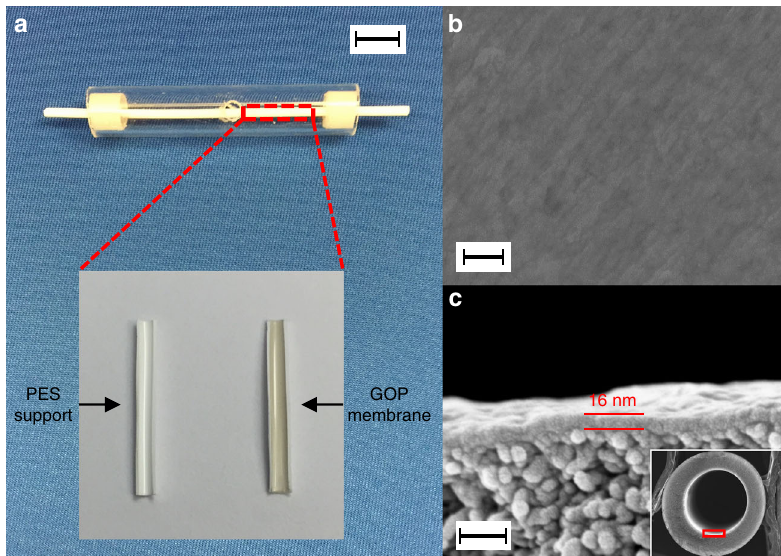
Fig. 2 GO-piperazine hollow fi ber membranes. a Digital picture of a GO-piperazine (GOP) hollow fi ber membrane housed in a Pyrex tube. The scale bar is 10 mm; inset shows the inner surface of PES support before (left) and after (right) depositing GOP coating. The effective separation length of the hollow fi ber membrane is 43 mm; the membrane was sealed in a Pyrex tube at two ends using epoxy, and two holes on each side were drilled into the Pyrex tube. The coated PES support surface shows a uniform dark gray color, suggesting a high-quality coating. b Surface and c cross-sectional SEM images of a GOP (10 wt.% piperazine) membrane. The scale bars in b and c are 200 nm and 50 nm, respectively